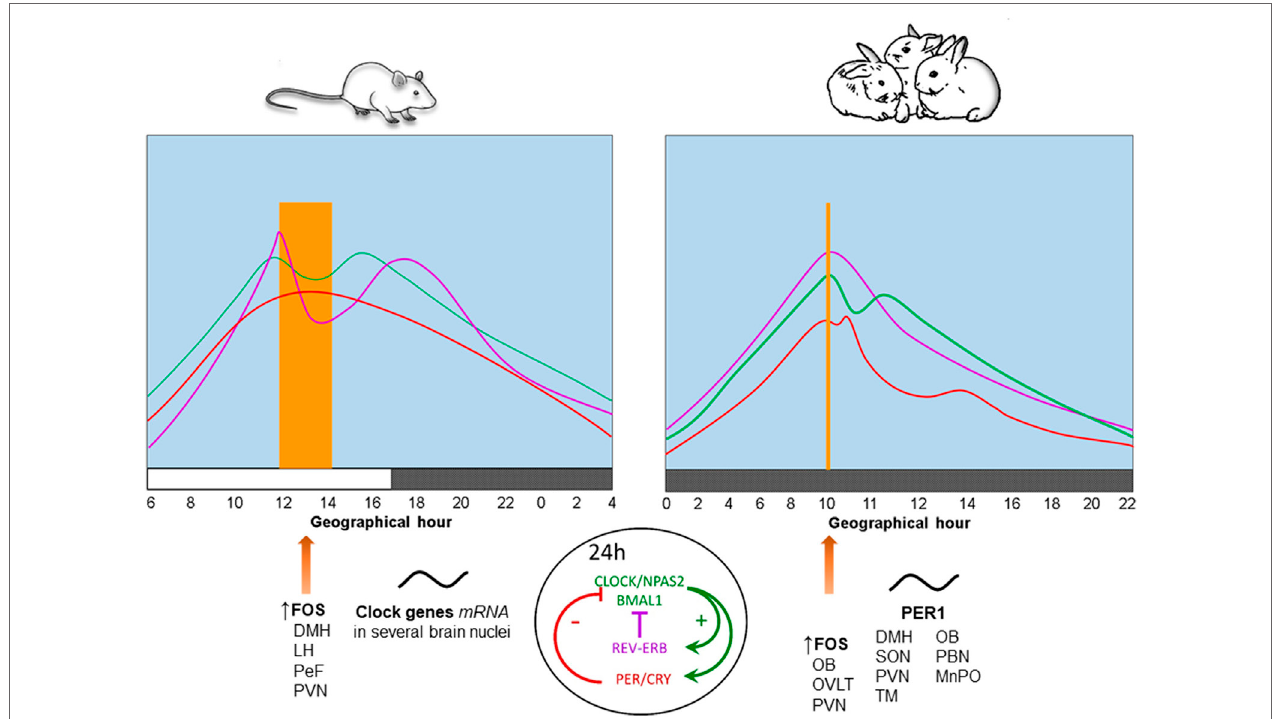
FiGURe 1 | Physiological, behavioral, and neural changes associated with food-anticipatory activity and the molecular clockwork. Daily rhythms of locomotor activity ( ), corticosterone ( ), and body temperature ( ) increase in anticipation of the time of feeding in both species. The molecular clock is comprised of two principal feedback loops for the expression of clock genes. In the positive loop (green) the proteins CLOCK/NPAS2 and BMAL1 act on the transcription sites of Per , Cry , and Rev-erb α genes to induce their mRNA expression. Once the final proteins of PER and CRY (negative loop; red) are produced, these have the ability to repress their own transcription via an inhibitory action on the Clock-Npas2/Bmal1 dimer. The REV-ERB α protein is a transcriptional repressor for the Bmal1 gene driving rhythmic Bmal1 . FOS protein expression and rhythms of clock genes and proteins in several brain nuclei synchronize to mealtime. DMH, dorsomedial hypothalamic nucleus; LH, lateral hypothalamus; MnPO, median preoptic nucleus; OB, olfactory bulb; OVLT, organum vasculosum of lamina terminalis; PeF, perifornical nucleus; paraventricular nucleus; SON, supraoptic nucleus; TM, tuberomammillary nucleus. Vertical bar and big arrow, feeding time. Figure derived from data previously published by: Angeles-Castellanos et al. (43), Caba et al. (37), Escobar et al. (44), Honma et al. (42), Jilge et al. (45), Mistlberger (7), Morgado et al. (40, 41, 46), and Rovirosa et al.